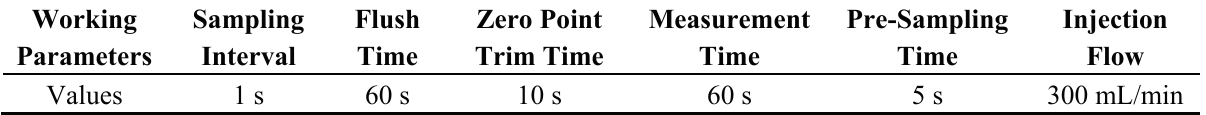
Table 2. The working parameter settings of the electronic